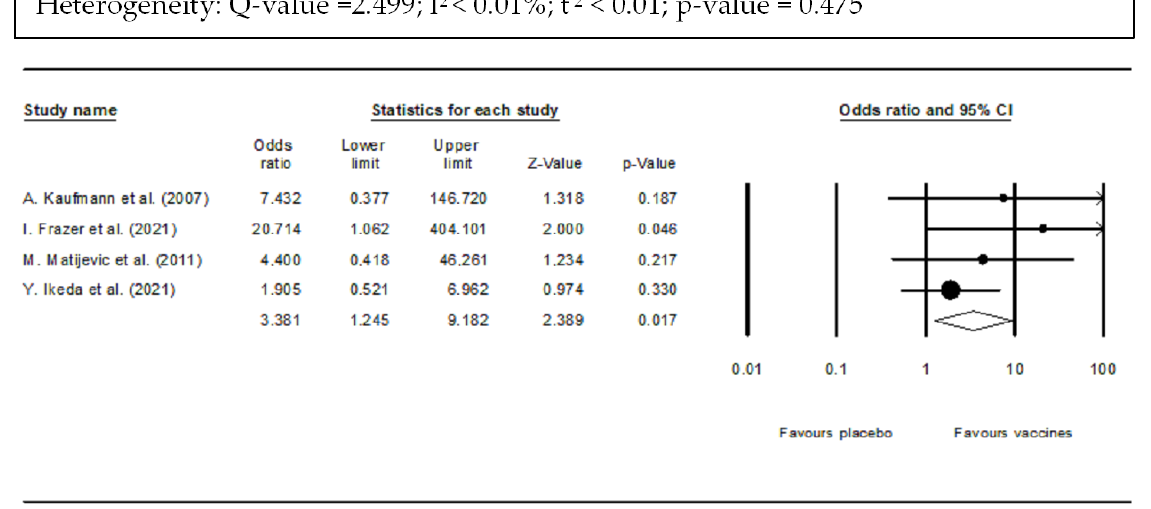
Figure 7. Forest plot of HPV-T cell response after vaccination compared with placebo.